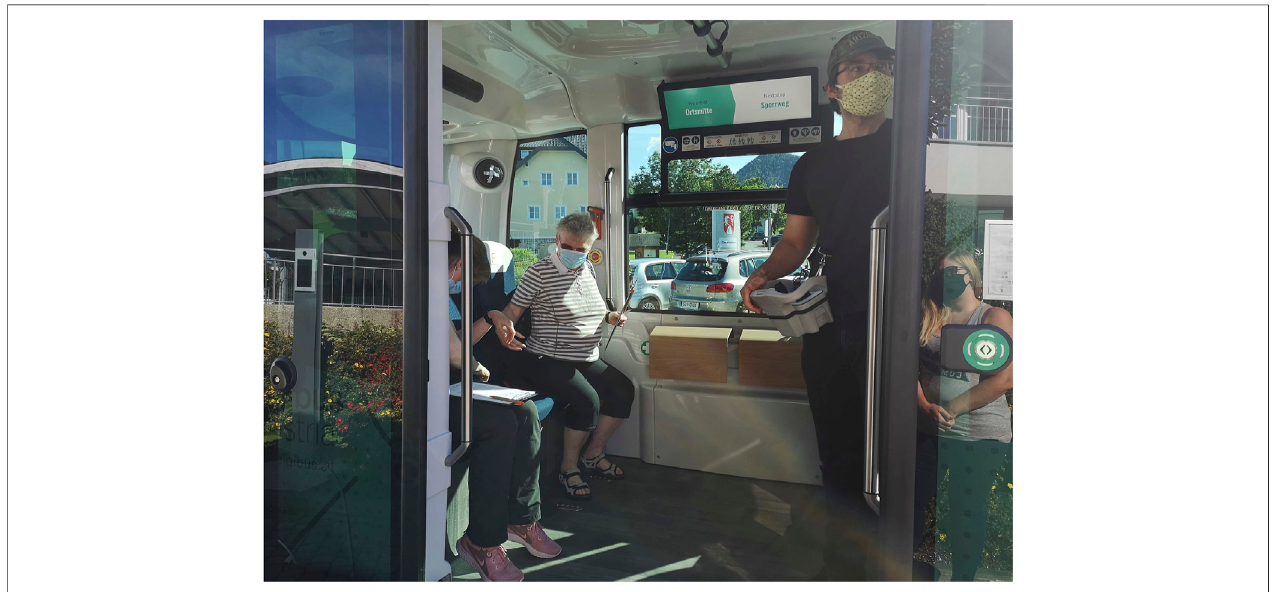
FIGURE 9 | Study 3: After boarding and before departure. Not visible: capacity management information screen behind operator on the right.